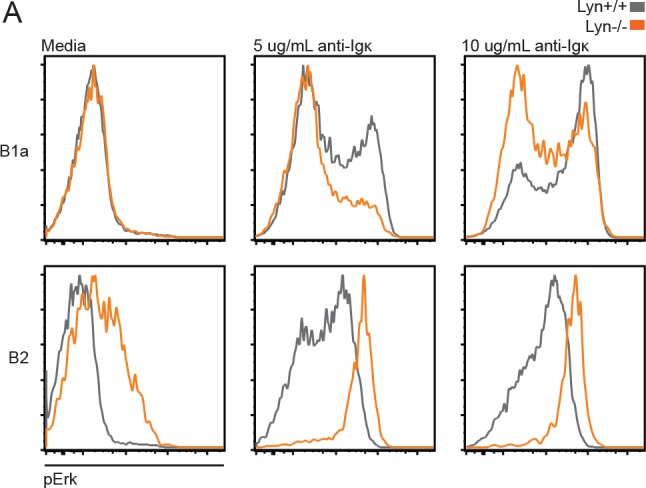
BCR signaling in Lyn−/− peritoneal B cell subsets.(A) Intracellular Erk phosphorylation in peritoneal B220+ B cells stimulated with anti-Igκ for 5 min. B1a (CD5+CD23-); B2 (CD5-CD23+). Histograms in (A) are representative of cells from n = 2 WT and Lyn−/− mice.